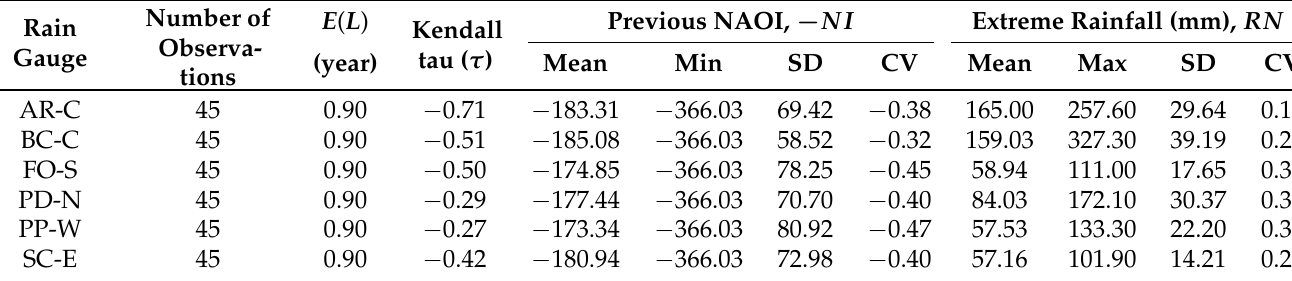
Table 3. Statistics of the bivariate observations (previous NAOI and extreme rainfall) at each rain gauge from 1967/1968– 2016/2017. E ( L ) is the expected interarrival time, and Kendall tau ( τ ) correlates the two